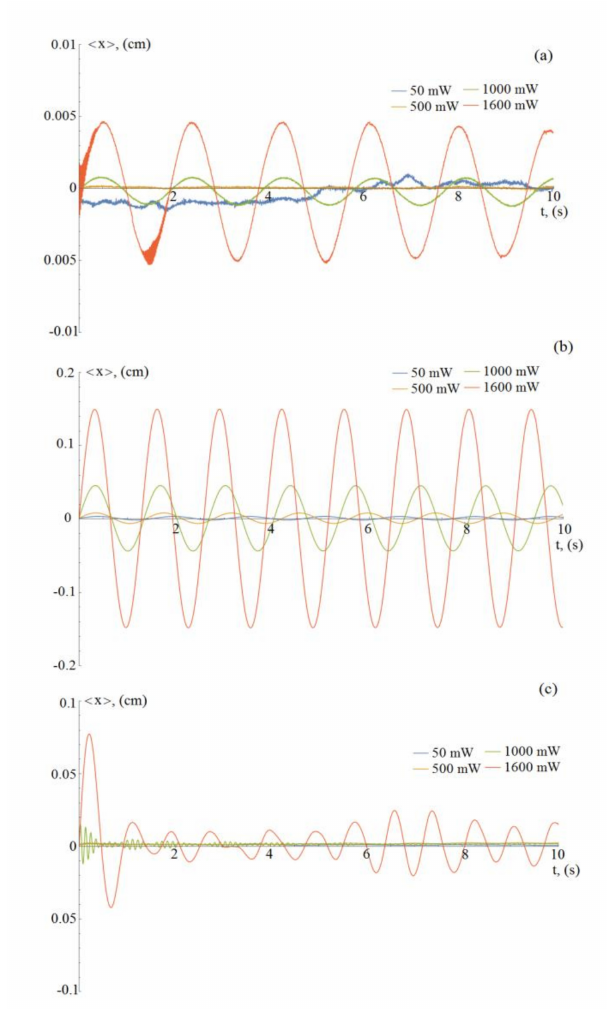
Figure 4. Linear displacements of a single dust particle during 10 s at a gas (argon) pressure of 3.5 Pa, under influence of laser radiation with a power of 50, 500, 1000 and 1600 mW: ( a ) uncoated particle, ( b ) Cu-coated particle, ( c ) Janus particle.